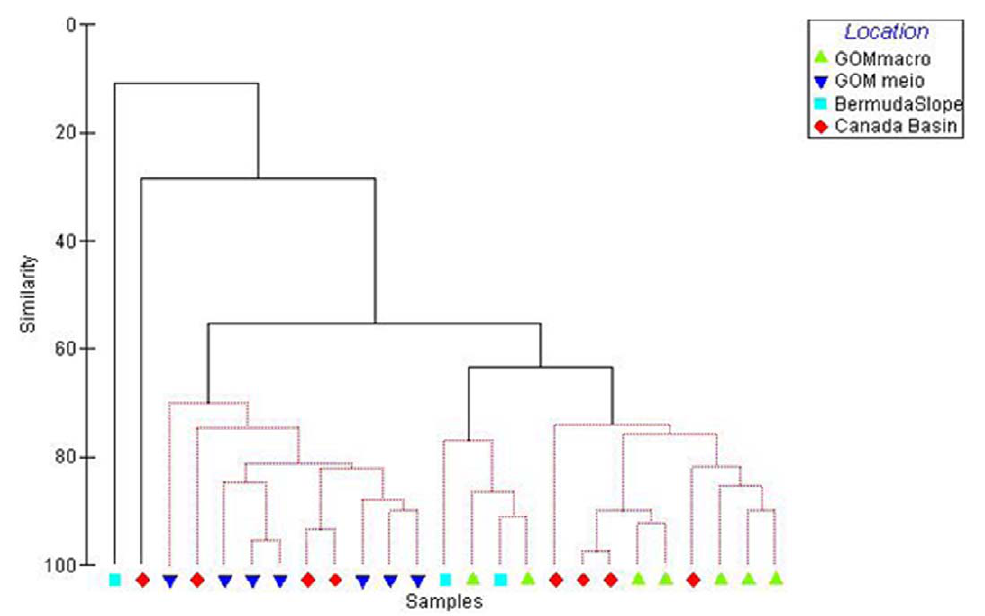
Figure 7. Cluster analysis with SIMPROF test on similarity of nematode feeding groups from meio- and macrobenthos in the Gulf of Mexico (GOM) and from macrobenthos in Canada Basin and Bermuda transect.